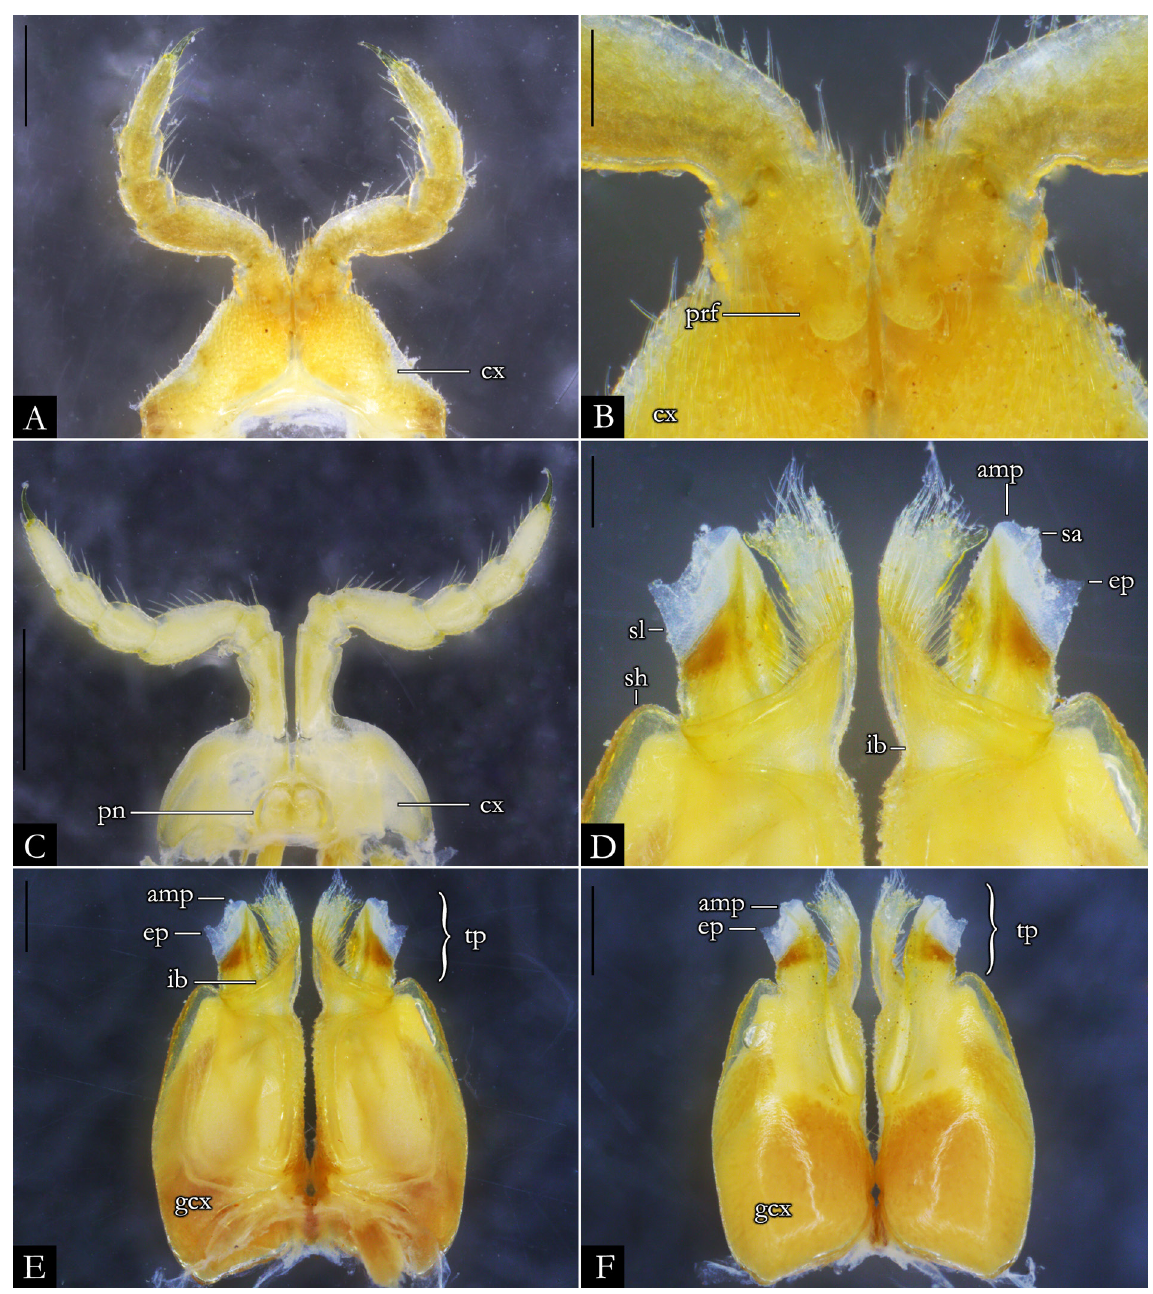
Fig. 114. Pseudonannolene robsoni Iniesta & Ferreira, 2014, ♂ (IBSP 3441). A . First leg-pair. B . Detail of prefemur. C . Second leg-pair. D . Detail of telopodites, in anal view. E . Gonopods, in anal view. F . Gonopods, in oral view. Abbreviations: see Material and methods. Scale bars: A, C, E–F = 0.5 mm; B, D = 0.2